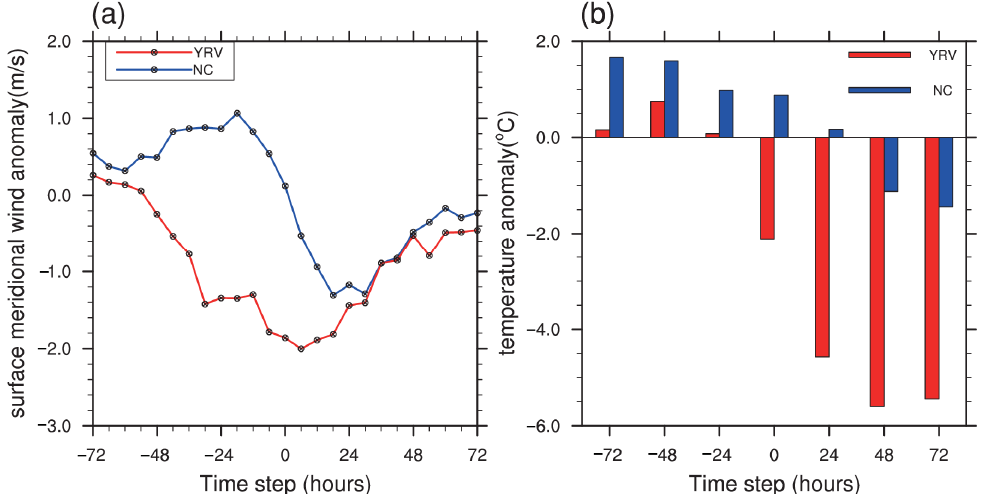
Figure 10. Evolution of ( a ) areal mean surface meridional wind anomalies (m/s) and ( b ) areal mean surface temperature anomalies (°C) over NC (in blue) and the YRV region (in red) in the 72 h before surface temperature anomalies ( ◦ C) over NC (in blue) and the YRV region (in red) in the 72 h before and after the breakout of ISEs. and after the breakout of